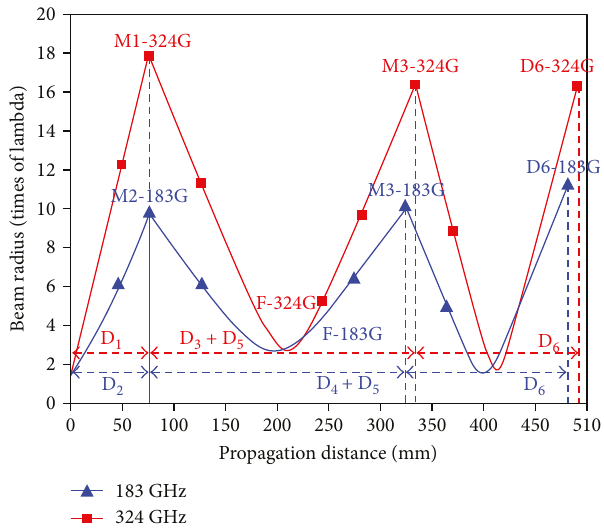
Figure 2: The changes of beam radius in the dual-channel 3D QON